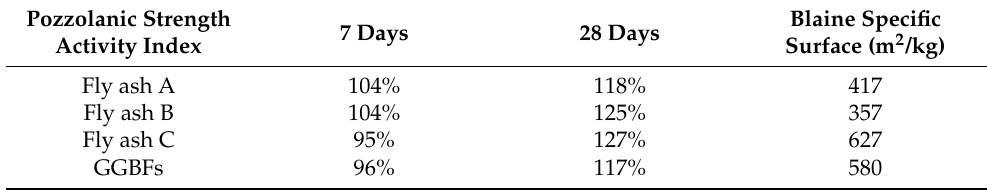
Table 3. Pozzolanic strength activity index and Blaine Specific surface area for each